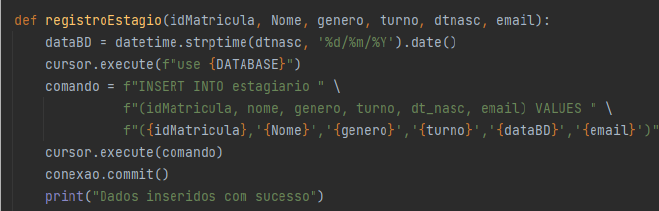
Figure 7: Function for registering an Intern in the database.